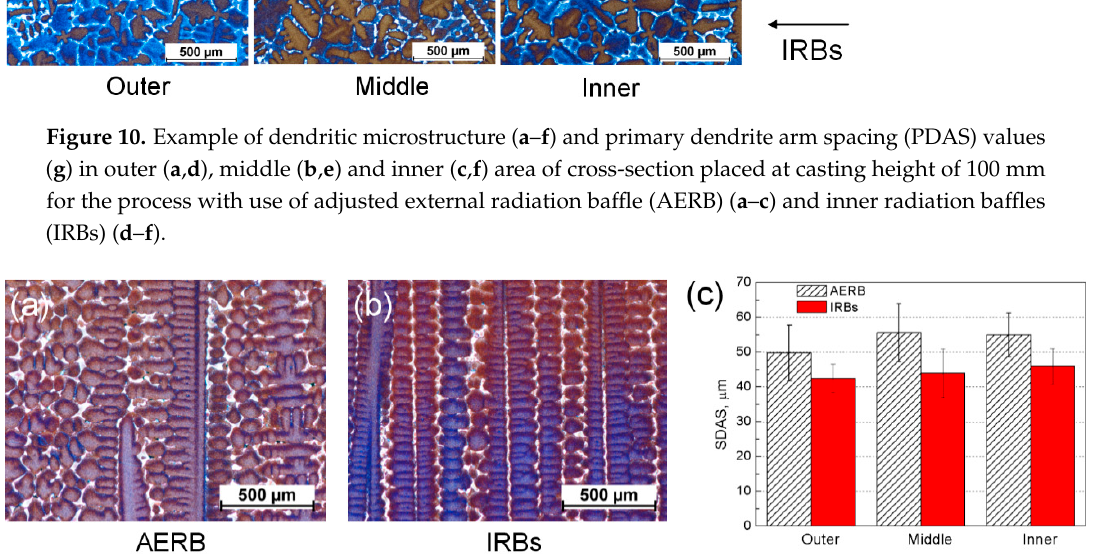
Figure 11. Example of the dendritic microstructure ( a , b ) in middle area of casting and secondary dendrite arm spacing (SDAS) values ( c ) at height 100 mm for the process with the use of adjusted external radiation baffle (AERB) ( a ) and inner radiation baffles (IRBs) ( b ).